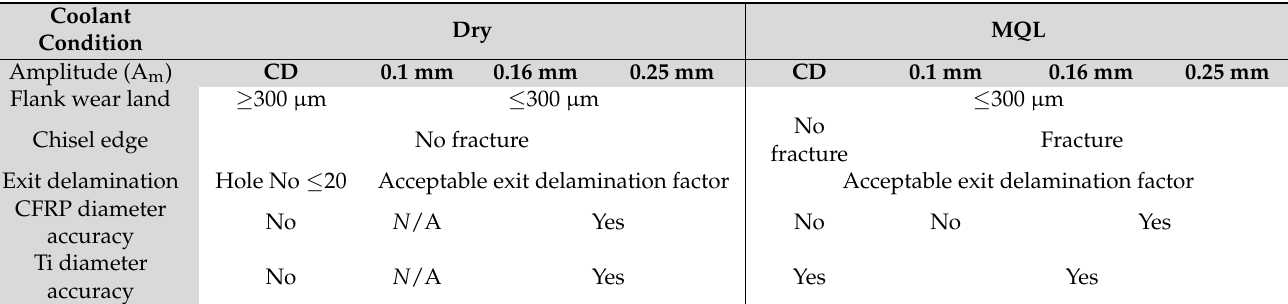
Table 4. Effect of coolant condition on the CFRP/Ti6Al4V drilling process at N = 2000